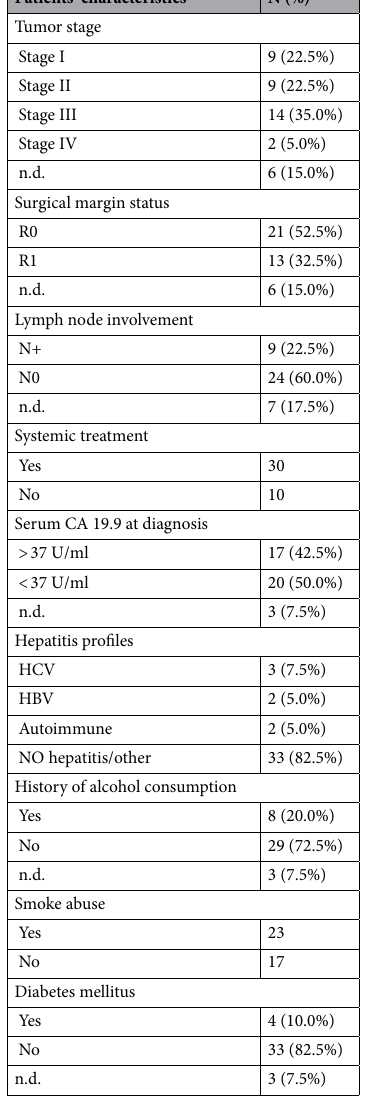
Table 1. Main clinical characteristics of the 40 enrolled patients. n.d. not